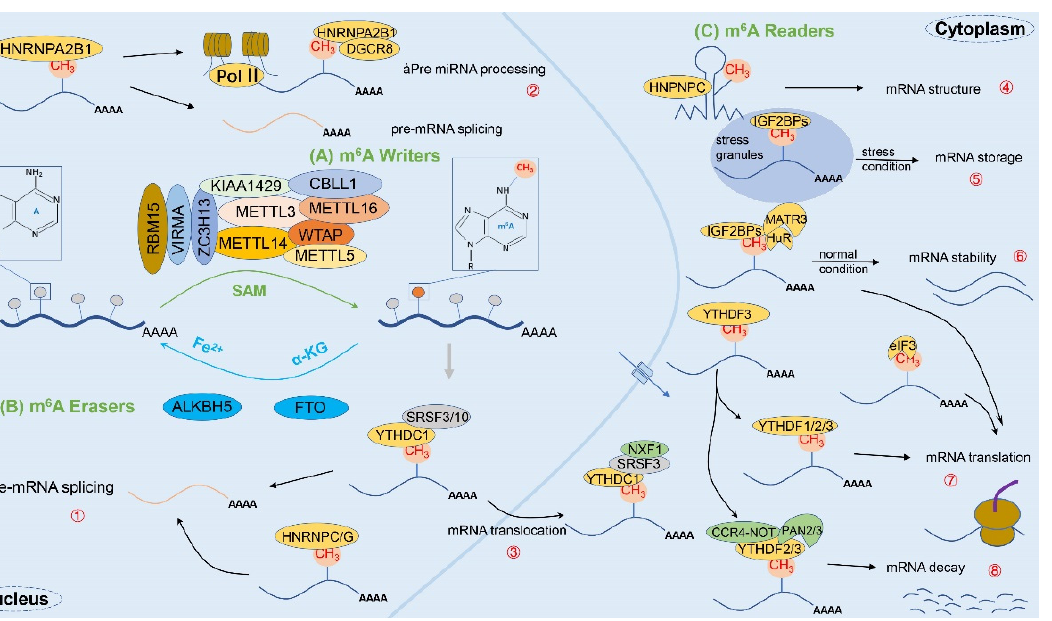
Figure 2. The complete process of m 6 A methylation modification. The m 6 A methylation modification is a dynamic and reversible enzymatic process and is strictly modulated by writers, erasers, and readers. ( A ) First, mRNA methylation is catalyzed by writers (e.g., m 6 A methyltransferases METTL3, METTL14, WTAP, RBM15, VIRMA, and ZC3H13, etc.); ( B ) Second, the process can be reversed by erasers (e.g., m 6 A demethylases FTO and ALKBH5); ( C ) Finally, the methylated mRNA will be recognized by readers (e.g., m 6 A binding proteins YTHDF1/2/3, YTHDC1/2, HNRNPs, IGF2BP, eIF3, etc.), thereby fulfilling the corresponding physiological roles. Specifically: ① mRNA splicing: YTHDC1, HNRNPA2/B1, HNRNPC/G, etc.; ② miRNA processing: HNRNPA2/B1; ③ mRNA translocation: YTHDC1; ④ mRNA structure: HNPNPC; ⑤ mRNA storage: IGF2BPs; ⑥ mRNA stability: IGF2BPs; ⑦ mRNA translation: YTHDF1/2/3, YTHDC2, IGF2BPs, eIF3, etc.; ⑧ mRNA decay: YTHDF2/3, YTHDC2.